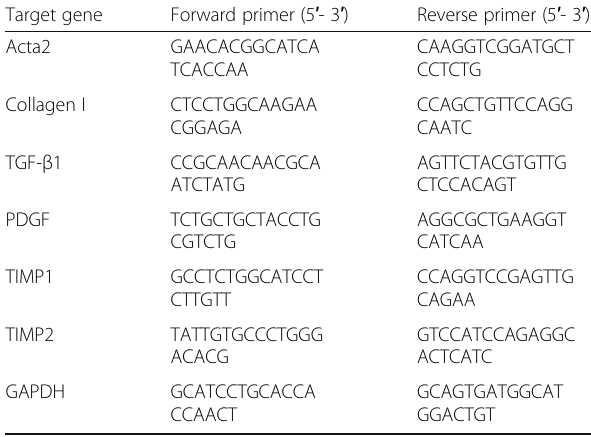
Table 1 Primer Sequences Used in This Study Target